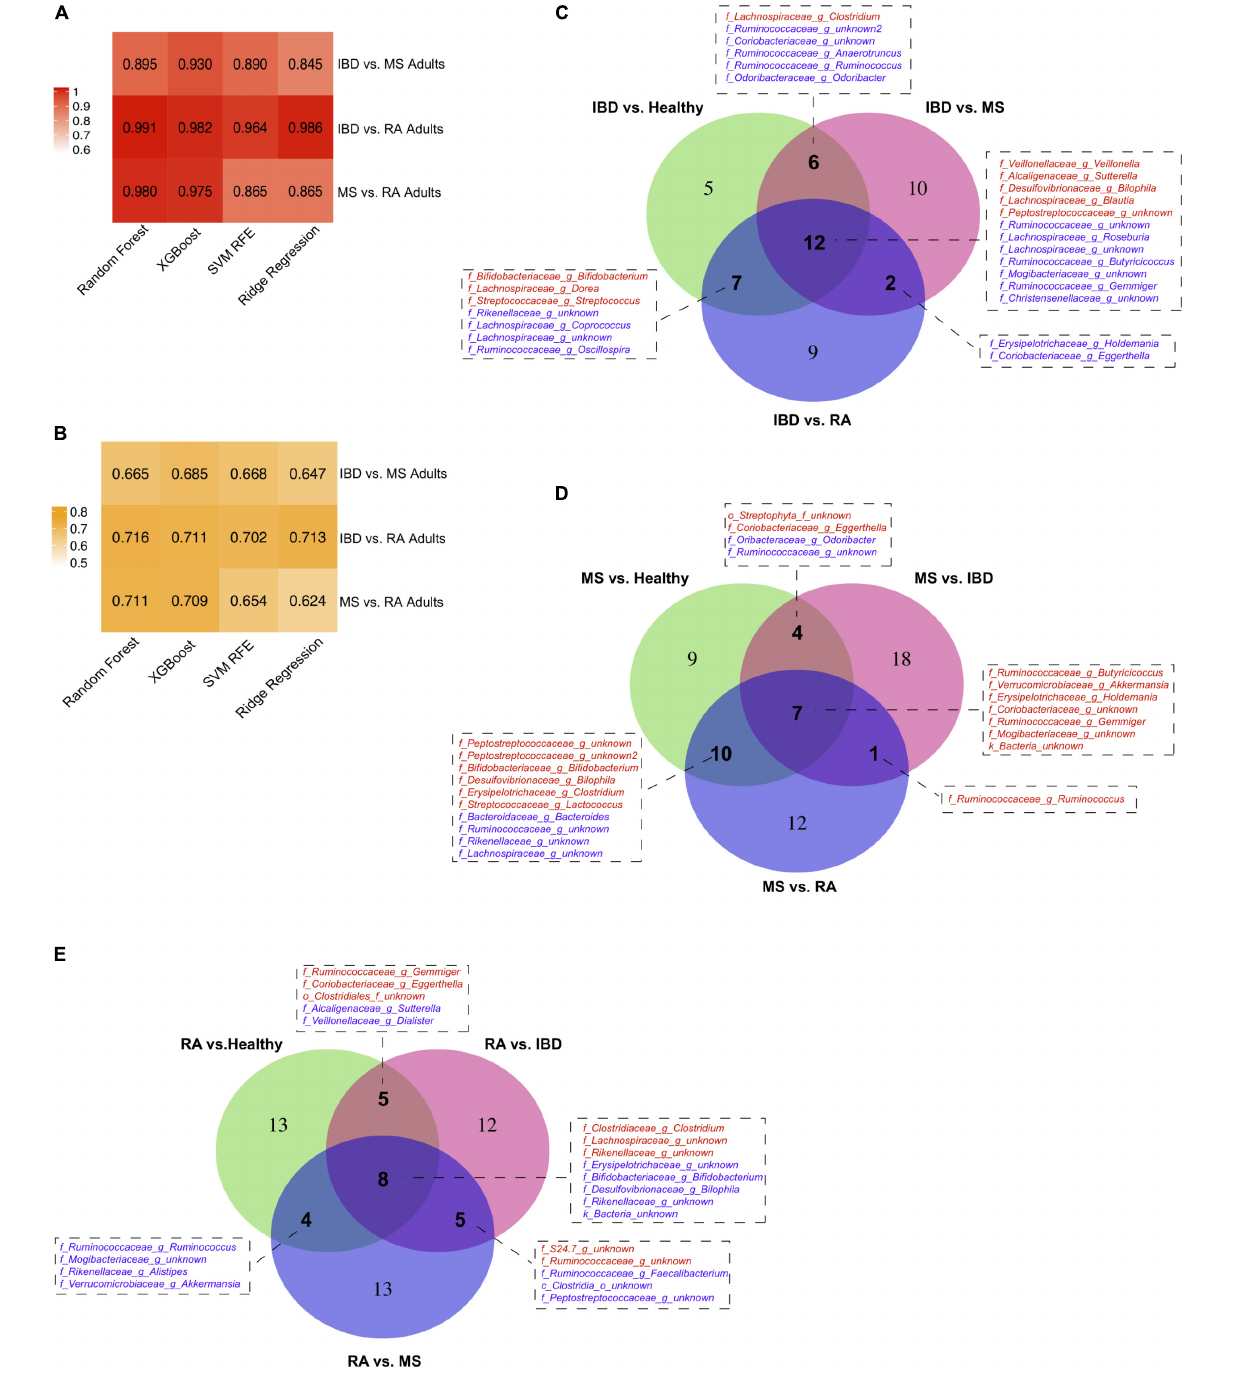
FIGURE 5 | Disease vs. disease comparison models. Model (A) AUCs and (B) F1 scores when predicting diseased samples when compared against other disease. Taxa consistently identified in multiple comparison models for (C) inflammatory bowel disease (IBD), (D) multiple sclerosis (MS), and (E) rheumatoid arthritis